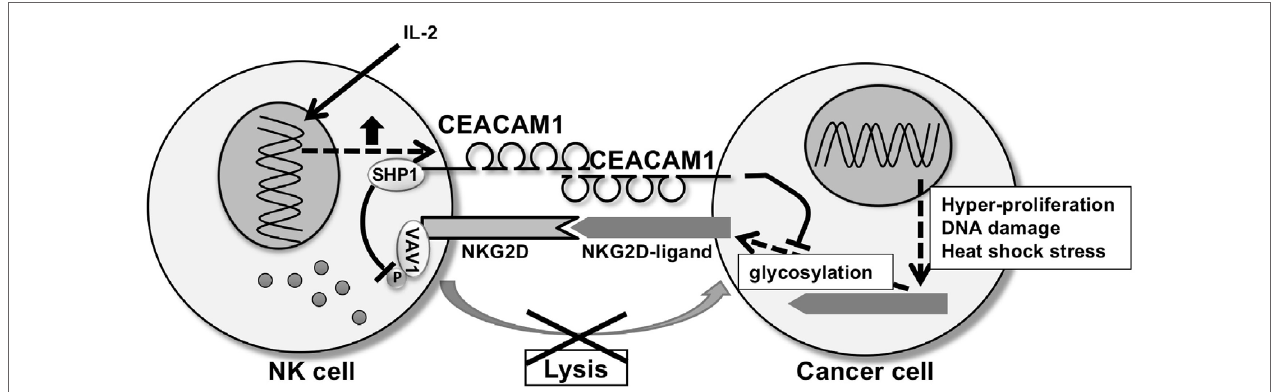
FiGURe 2 | CEA-related cell adhesion molecule 1 (CEACAM1) regulating natural-killer group 2 member D (NKG2D)-ligands expression and NKG2D function. CEACAM1 regulates glycosylation of NKG2D-ligands, resulting in downregulation of the NKG2D-ligand expression on the cell surface of the tumor cell. CEACAM1 induced by interleukin-2 inhibits NKG2D-mediated cytotoxic function through recruitment of Src homology phosphatase 1 (SHP1) to phosphorylated CEACAM1 which leads to dephosphorylation of Vav1 on the natural killer (NK) cell. CEACAM1 on the NK cell and tumor cell interact homophilically through the N-domain of